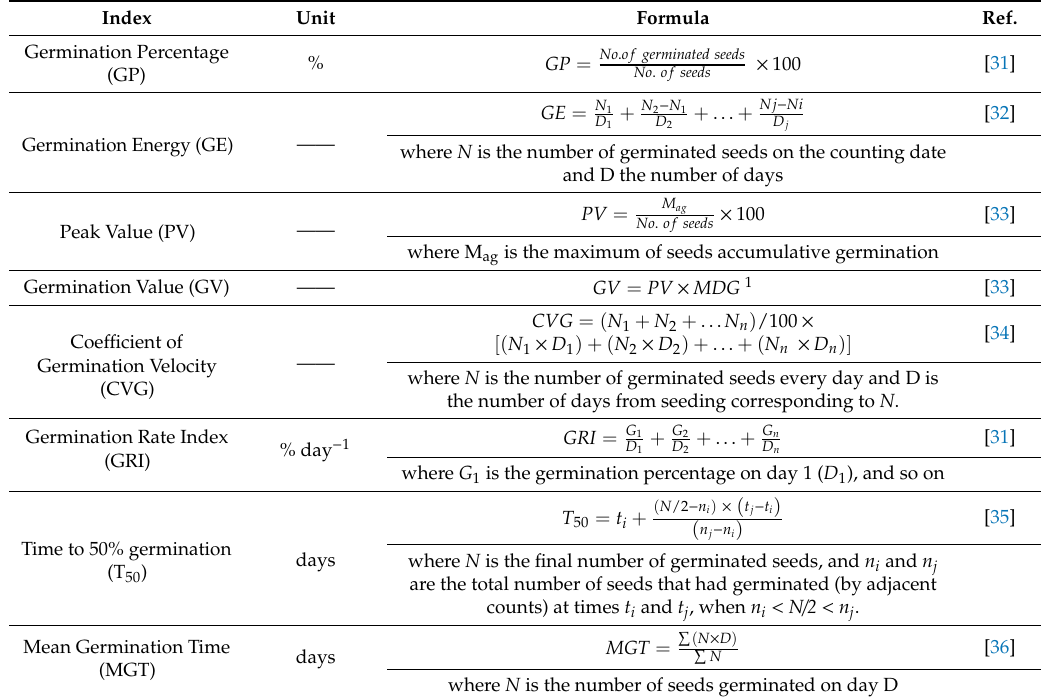
Table 1. Description of the various germination indices used in this